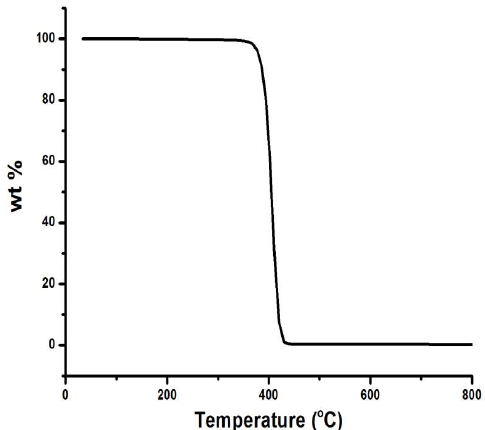
Figure 2. Thermogravimetric of waste leaves.